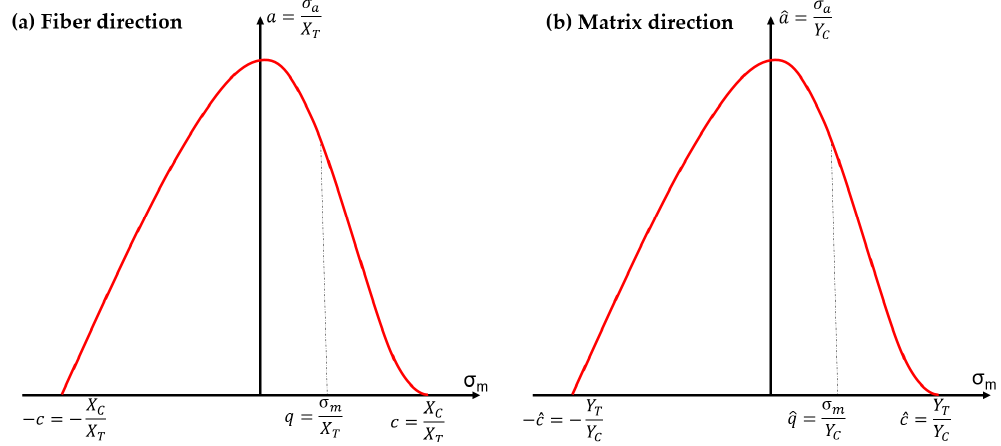
Figure 2. Unified parameter determination for ( a ) fiber direction; ( b ) matrix direction loading.